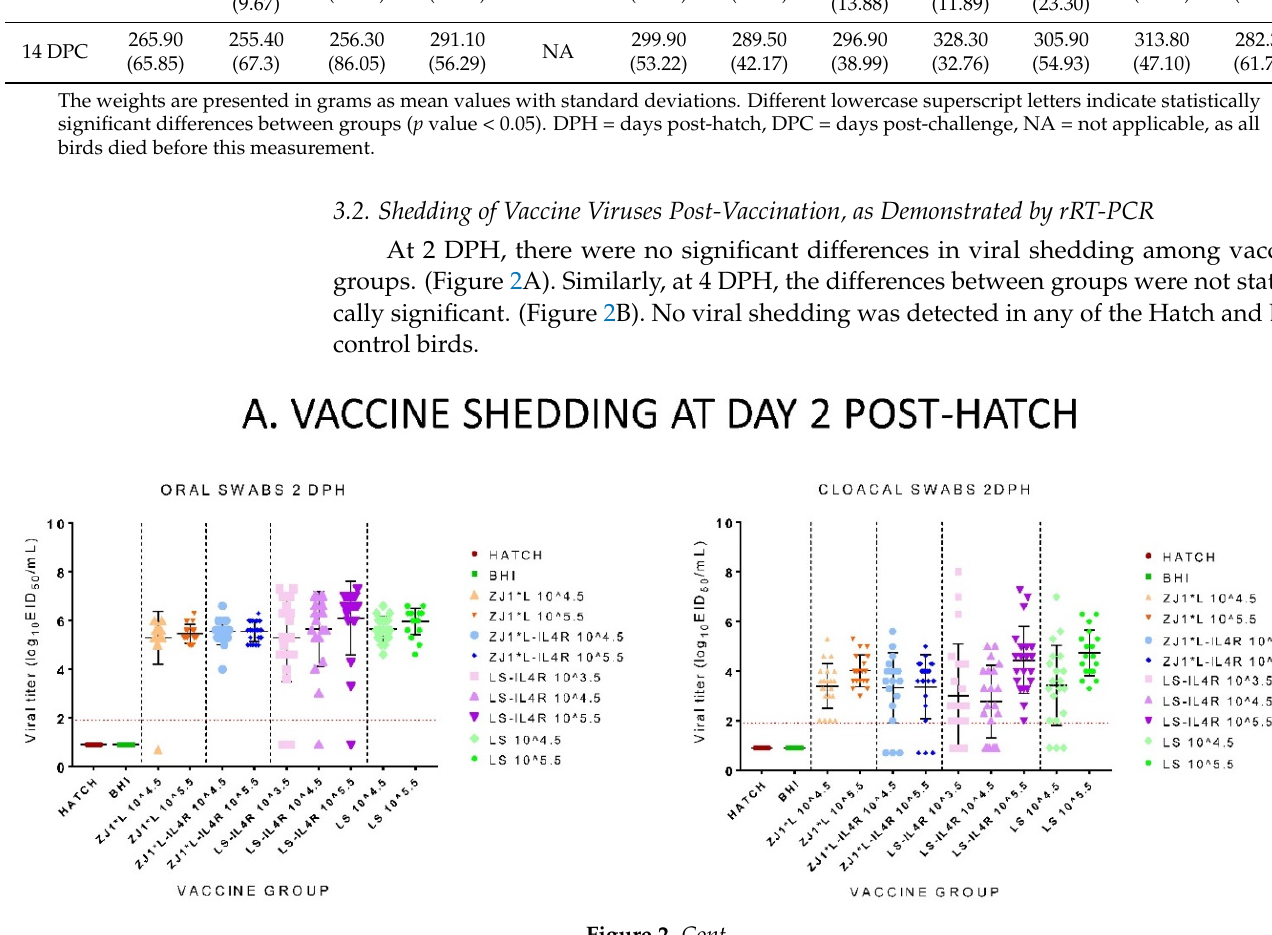
Figure 2. Mean post-hatch vaccine shedding from chickens hatched from commercial eggs inoculated at 18 days of em- bryonation with experimental in ovo vaccines. Each data point represents one bird and NDV titers detected in oropharyn- geal (OP) and cloacal (CL) swabs at different days post-hatch (DPH). Shedding is presented separately for 2 days post- hatch (A) and 4 days post-hatch (B). Bars represent standard deviations of the mean. All swabs from which virus was not detected were given a numeric value of 1 log below the limit of detection for each of the respective viruses. The limit of detection of rRT-PCR is presented as a horizontal dotted line (the lowest limit is used). Group abbreviations: HATCH— eggs not inoculated; BHI—eggs inoculated with BHI; rHVT-ND—eggs inoculated with recombinant HVT vaccine; ZJ1*L— eggs inoculated with the recombinant ZJ1*L virus whose cleavage site was modified to be of low virulence; ZJ1*L-IL4R— eggs inoculated with the recombinant low virulent ZJ1*L with the interleukin-4 gene inserted in reverse orientation; LS— eggs inoculated with the LaSota strain; LS-IL4R—eggs inoculated with the recombinant LaSota virus with the interleukin- 4 gene inserted in reverse orientation. The virus dose that the eggs in each group received is represented as a number after the group name in EID 50 /per egg.